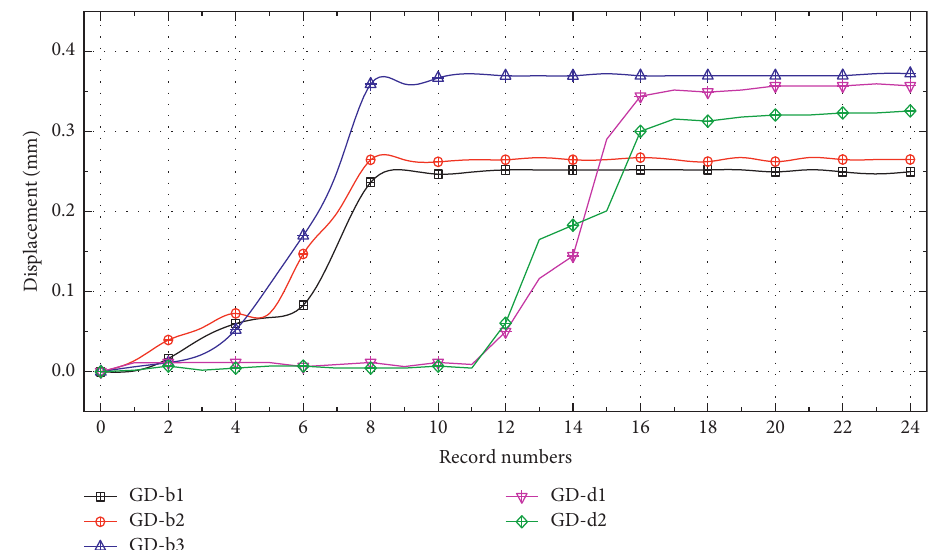
Figure 13: Variation curves of surrounding rock and lining stresses with excavation